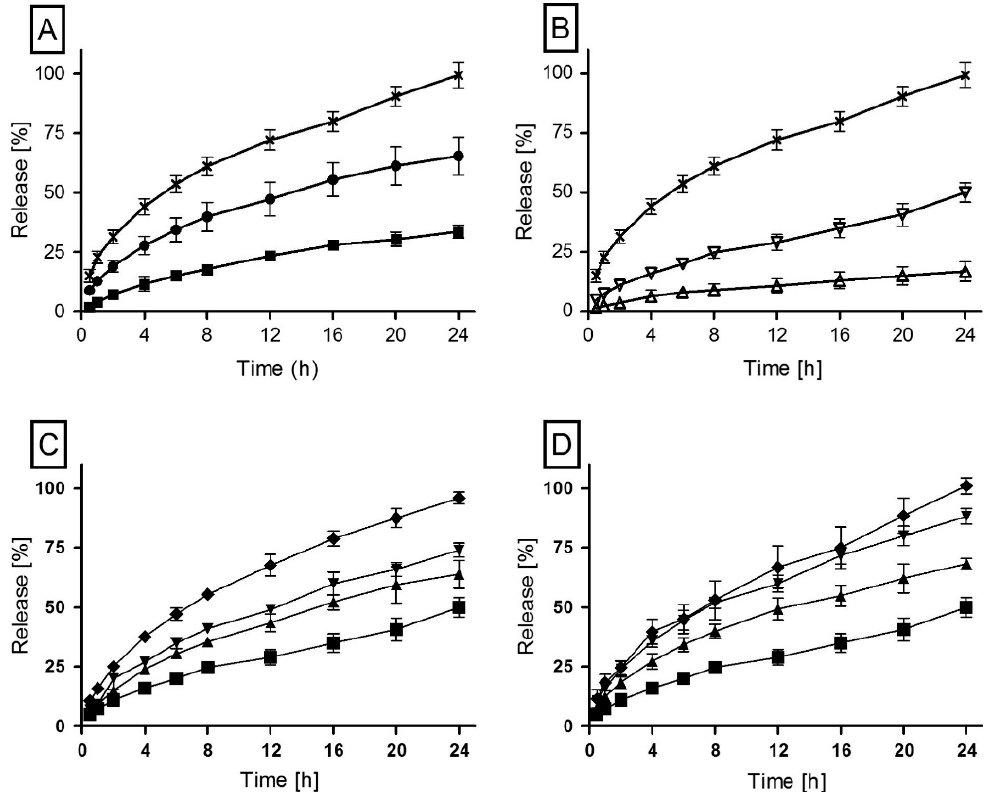
Figure 6. Mean dissolution profiles (±SD) of polyester-based polyurethane (Pearlbond) matrices as a function of ( A ) drug load: 50% ( ), 60% ( ) and 65% ( ) metoprolol tartrate; ( B ) drug solubility: 65 wt % theophylline ( ), diprophylline ( ) and metoprolol tartrate ( ); pore former ( C ) PEG 4000 or ( D ) Polysorbate 80; 65 wt % diprophylline with 0% ( ), 2% ( ), 5% ( ) and 10% ( ) of pore former, respectively. Adapted from [60], Elsevier, 2015 with permission.